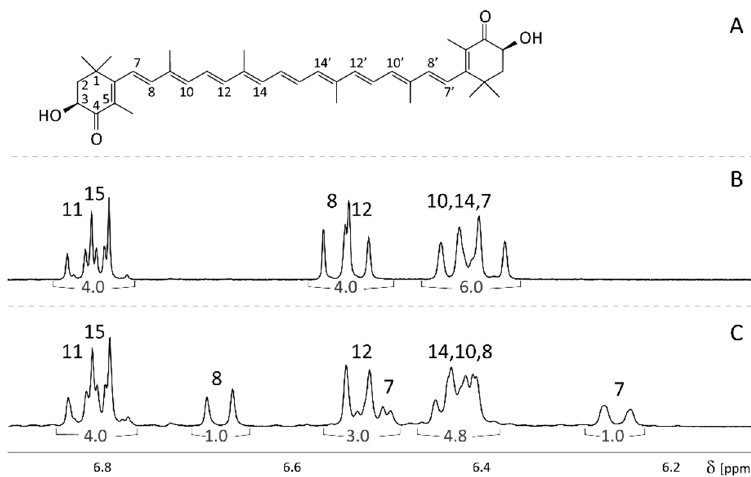
Figure 1. The structure of astaxanthin ( A ) and 1 H NMR spectra of the astaxanthin standards in acetone at 300 K (600 MHz). ( B ) Natural astaxanthin (Ax); ( C ) 7,7 ′ , 8,8 ′‐ 13 C ‐ enriched astaxanthin (13C ‐ Ax). The numbers over the spectra show the resonance assignment (symmetrical hydrogens are shown with the same number). The numbers in buckets below the spectra show the relative integral values. δ – chemical shift in parts per million (ppm).